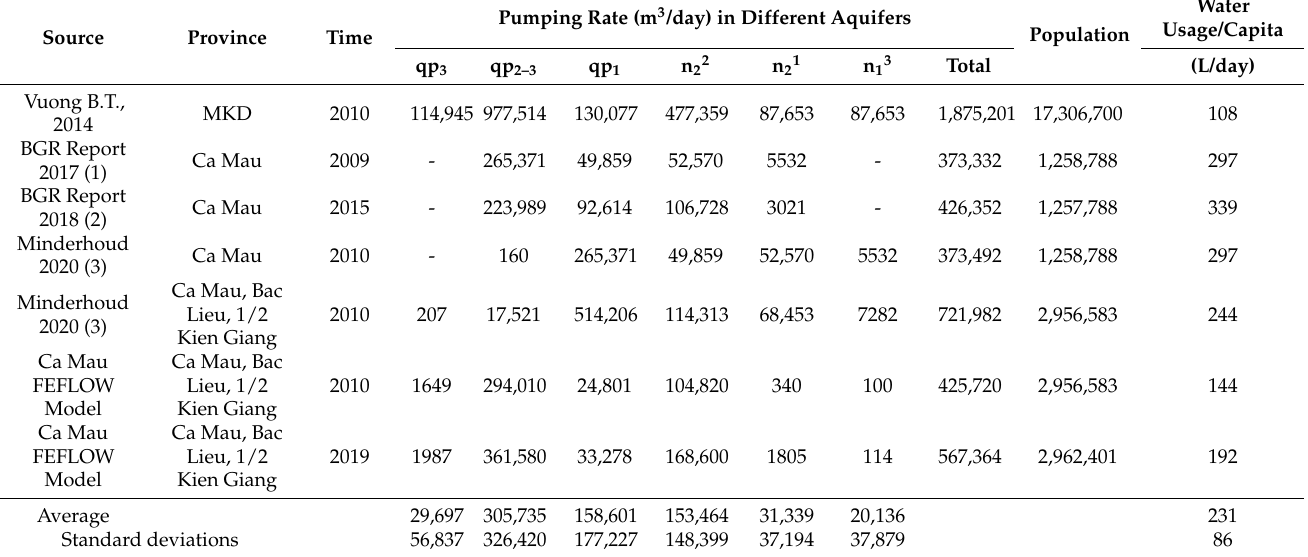
Table 4. Different sources for pumping